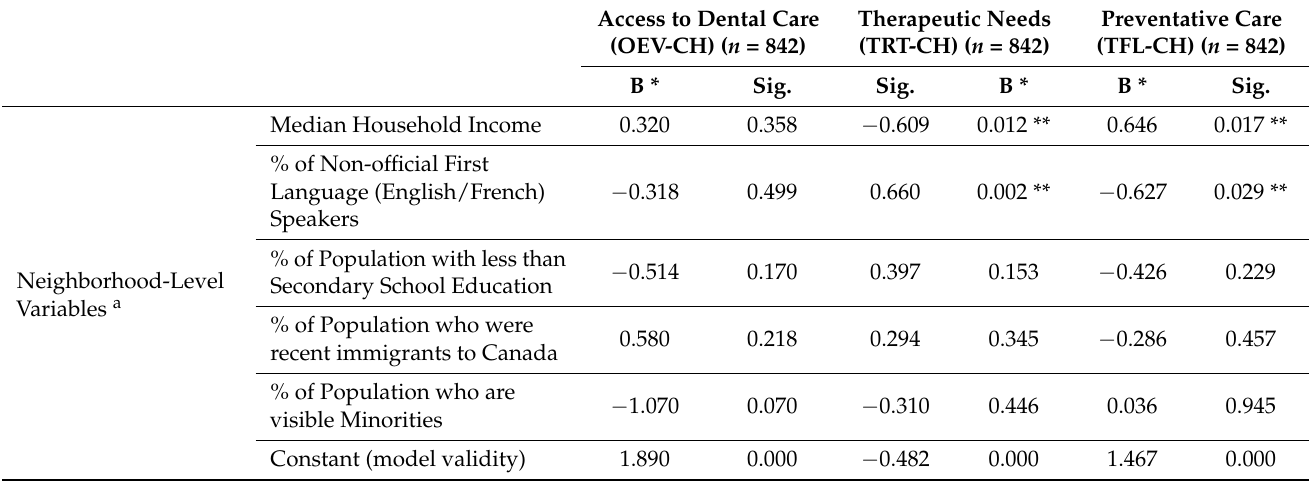
Table 3. Impact of neighborhood (FSA)-level demographic variables on the presence or absence of dental treatment outcome variables in the